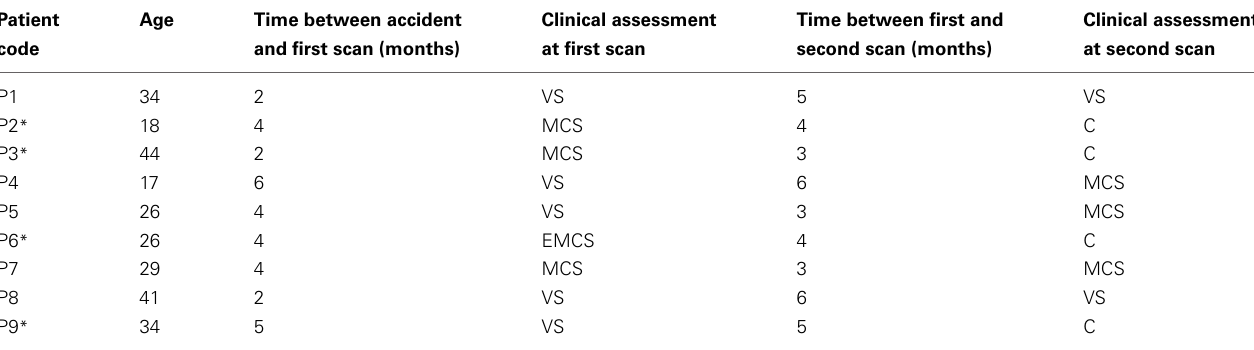
Table 1 | Clinical characteristics of DOC